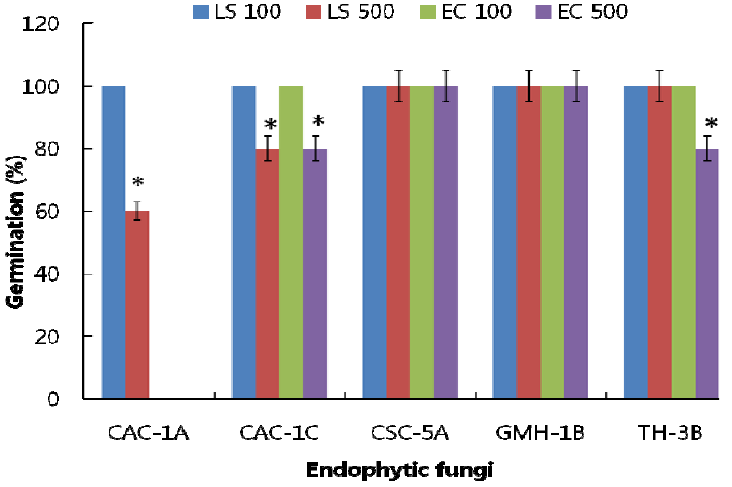
Figure 1. Effect of culture filtrate application of selected endophytic fungal strains on the germination of Lactuca sativa (LS with 100 and 500 ppm) and Echinochloa crus - galli (EC with 100 and 500 ppm) seeds. The ‘*’ indicates that values are significantly different ( p < 0.05). The error bars represents ± SD ( n =